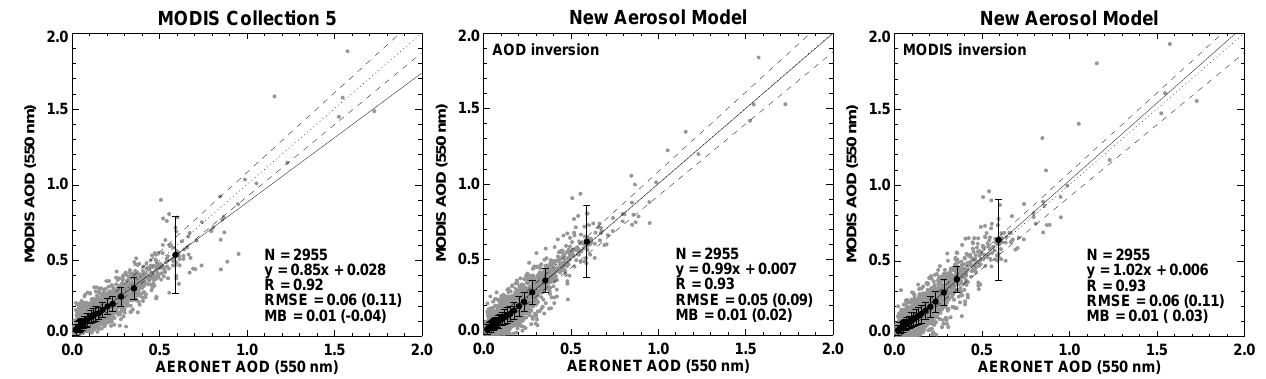
Fig. 6. Comparison of AOD between AERONET and MODIS over the global ocean for the period from 2003 to 2010. The MODIS AODs are from the C005 algorithm (left) and the test algorithm (middle and right) with new aerosol models. Two different inversion procedures using standard deviation of spectral AOD (middle) and MODIS operational inversion (right) are applied for the test algorithm. The collocation criteria of ± 30 minutes in time and 25km in space were used. The gray dots represent all data points, whereas black dots with one- standard deviation interval represent mean AODs in 20 equal-number-of-data bins with respect to the AERONET data. The solid line is from the regression equation, while the dotted and dashed lines are the one-to-one line and the MODIS expected error (EE) line showing ± (0.03+0.05 × AOD), respectively. Only data points overlapping between the two algorithms are compared. Originally, the number of data points was 3106 for the C005 algorithm and 3578 for the test algorithm. The statistics shown are the Pearson coefficient ( R ), root mean squared error (RMSE), mean bias (MB), and the number of data points ( N ). Table 3. Statistics for a comparison of AOD retrieved from the MODIS C005 algorithm and AERONET observations from 2003 to 2010 over the global ocean. The numbers in the parentheses are for AOD (AERONET) >